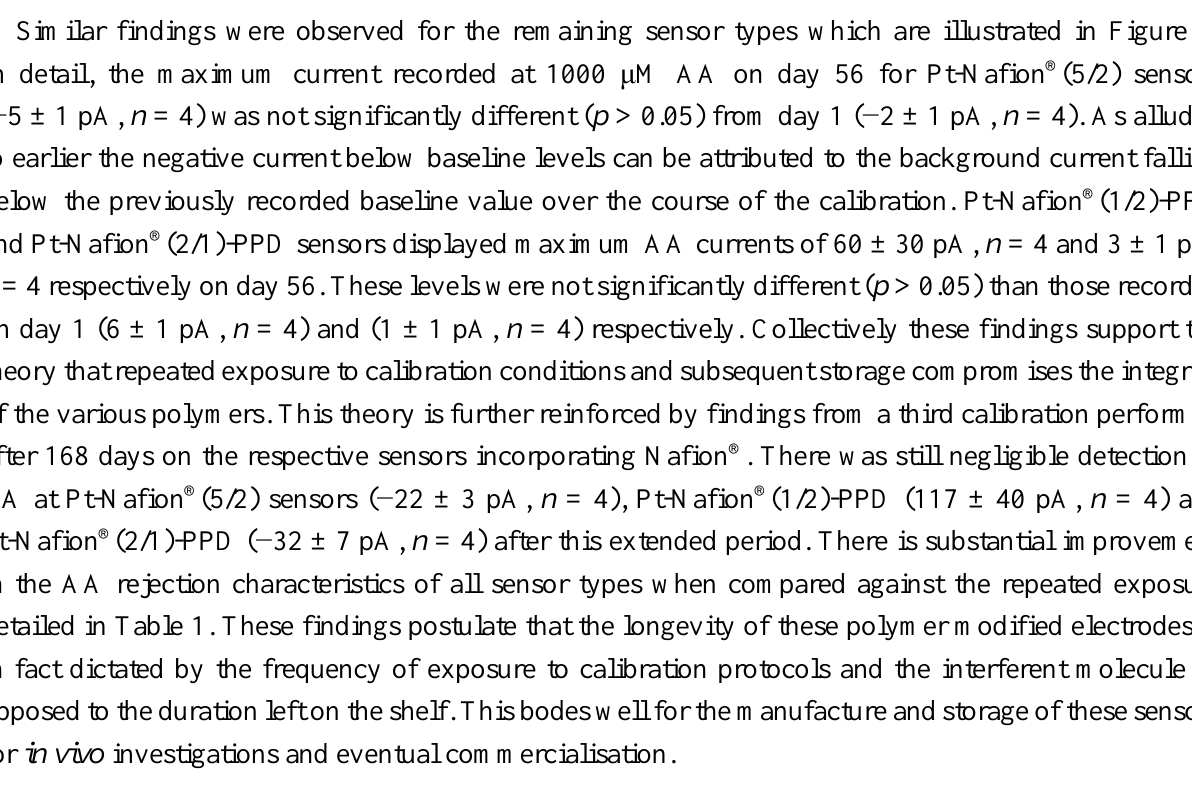
Figure 4. A current-concentration profile for 0–1000 μM AA on Pt-PPD electrodes on day 1 ( n = 4, solid line) vs. day 56 (4 °C storage, n = 4, dashed line) at +900 mV vs. SCE. Electrodes calibrated on day 1 and 56. (Inset) Typical raw data trace. Arrows indicate injection of AA